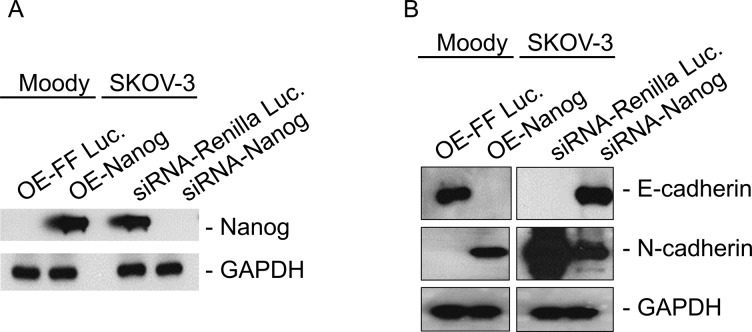
NANOG expression regulates the expression of EMT markers in ovarian cancer cells(A) Successful ectopic overexpression in Moody cells and RNAi-mediated silencing of NANOG expression in SKOV-3 were confirmed by Western blot analysis. The blot was stripped and probed with GAPDH antibody to serve as loading control. (B) Whole-cell lysates in indicated cells were probed for expression of E-cadherin and N-cadherin. The blots were probed with anti-GAPDH antibody to confirm equal loading.